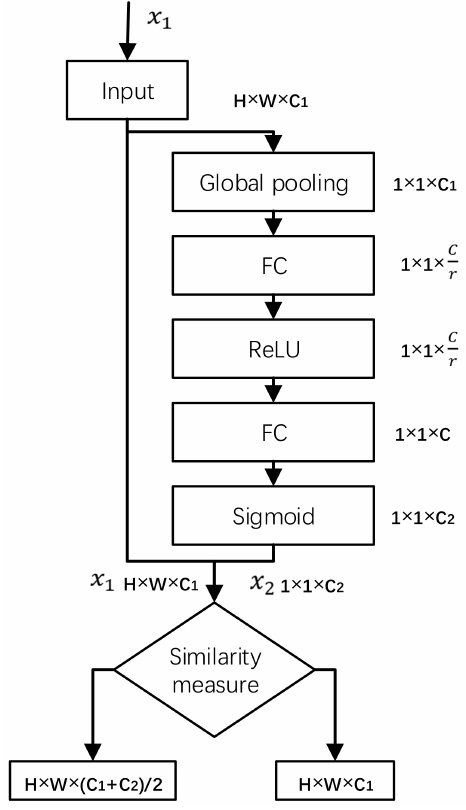
Figure 5. SASE module.